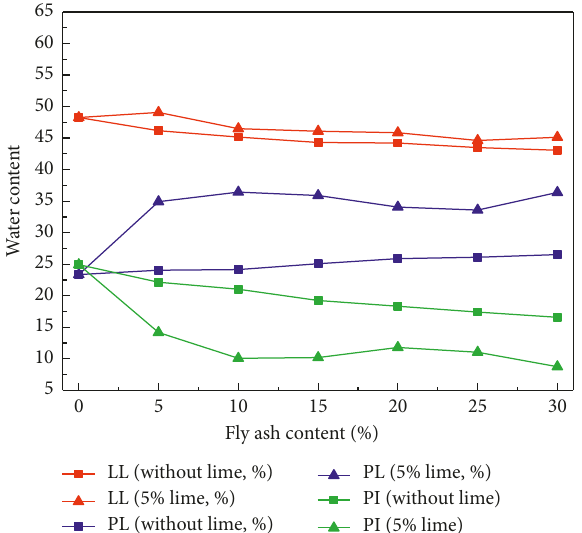
Figure 3: Variation laws of LL, PL, and PI under different fly ash and lime content.